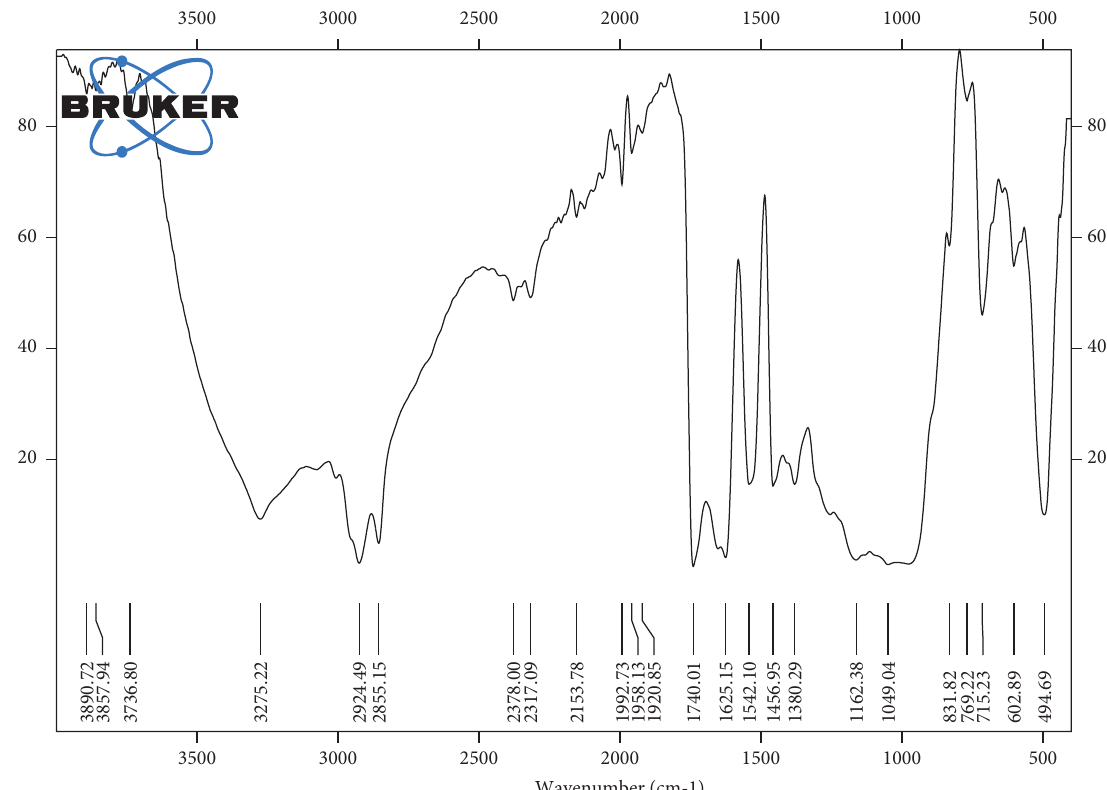
Figure 16: FTIR spectrum of partially purifed biosurfactant produced by P. guguanensis strain Iraqi ZG.K.M.